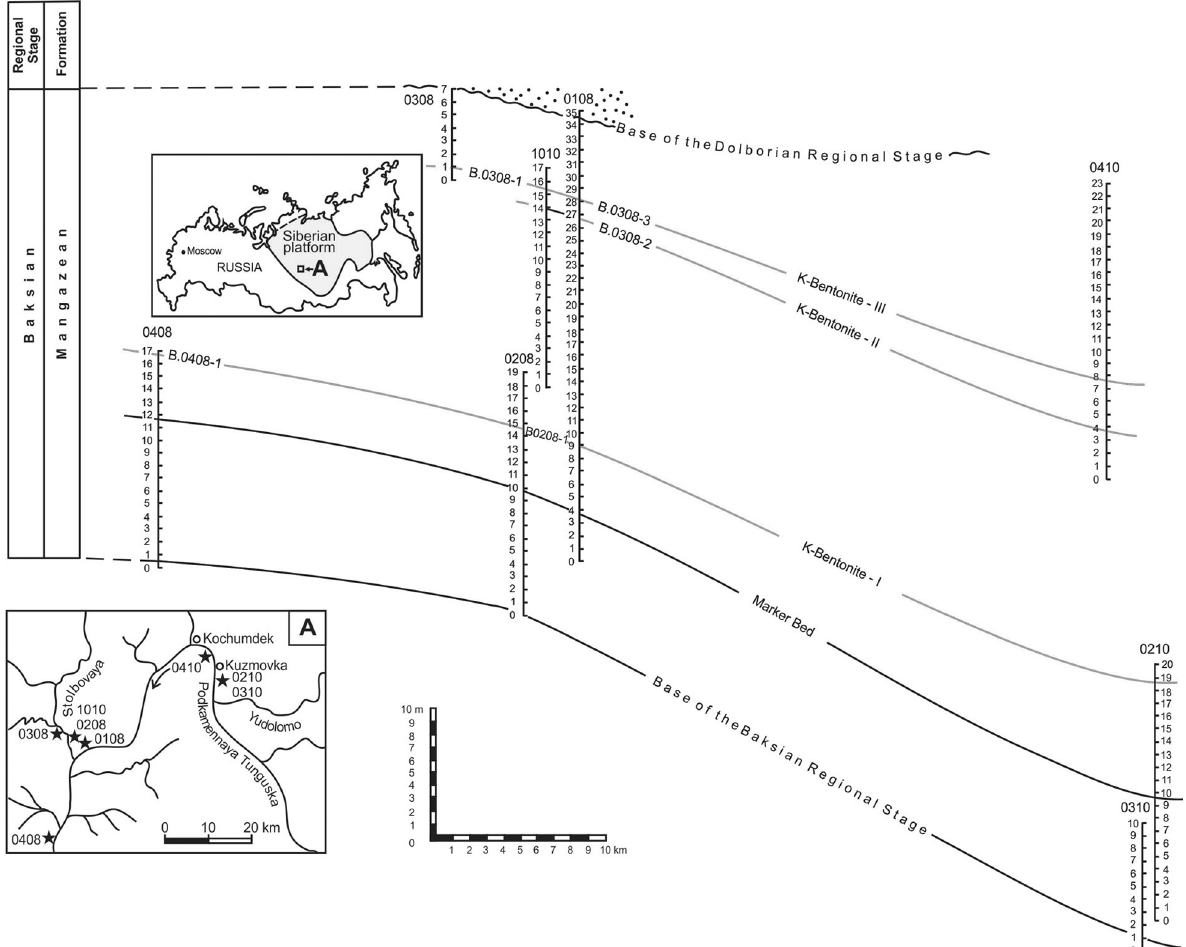
Fig. 1. Stratigraphic distribution and correlation of Upper Ordovician K-bentonite beds in the Siberian